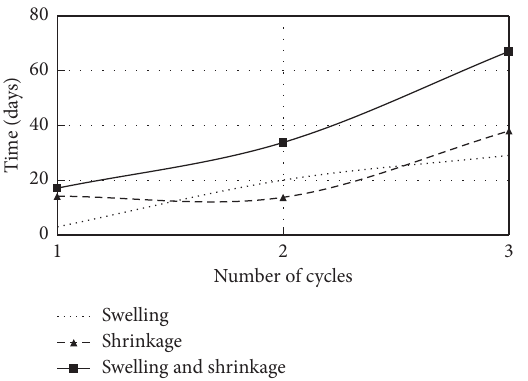
Figure 15: Reduction factor versus the number of cycles for UECS and TECS.